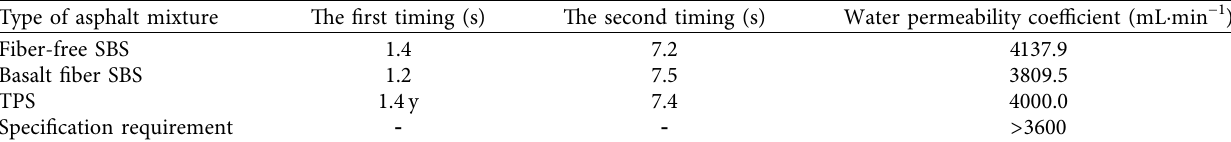
Table 18: Seepage test